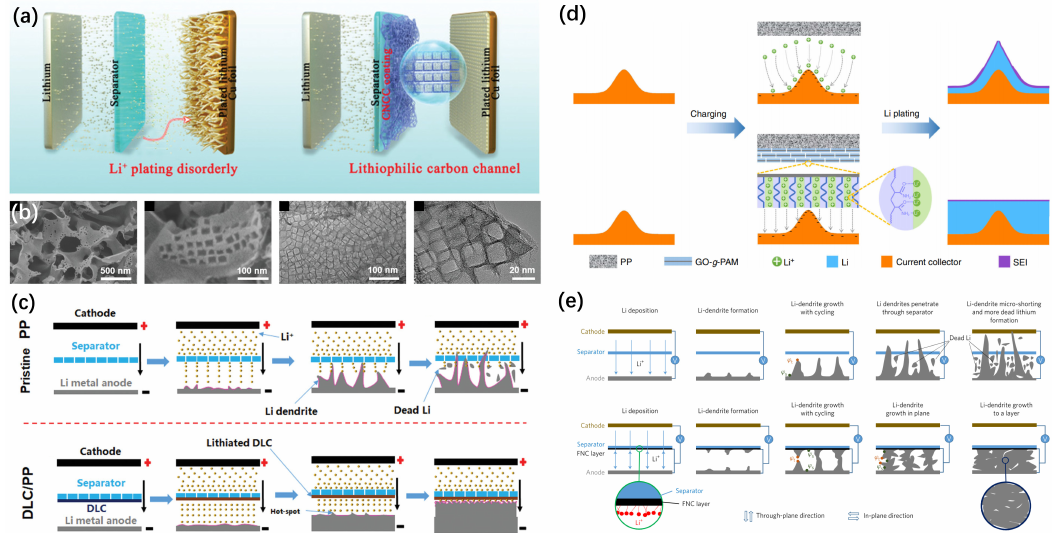
Figure 7. ( a ) Schematic illustration of Li-ion deposition in batteries with pristine separators or CNCC-coated separators. ( b ) SEM and TEM images of the CNCC coating [81]. ( c ) Schematic illustration of Li dendrite growth in pristine PP and LMB based on DLC/PP separator [82]. ( d ) Schematic illustration of Li ion deposition on electrodes with microscopic surface roughness [25]. ( e ) Growth of dendrites in blank cells and FNC cells [84].